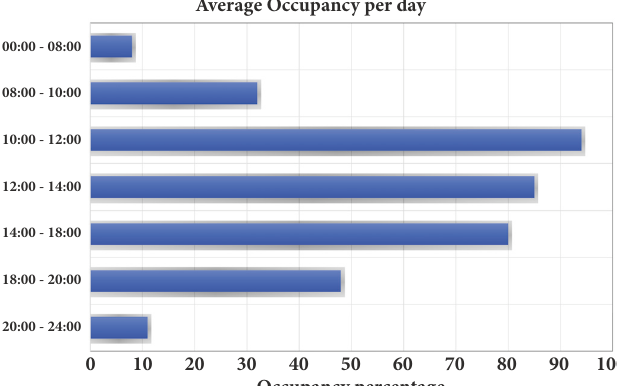
Figure 12: Average parking lots occupancy per day in outdoor parking.